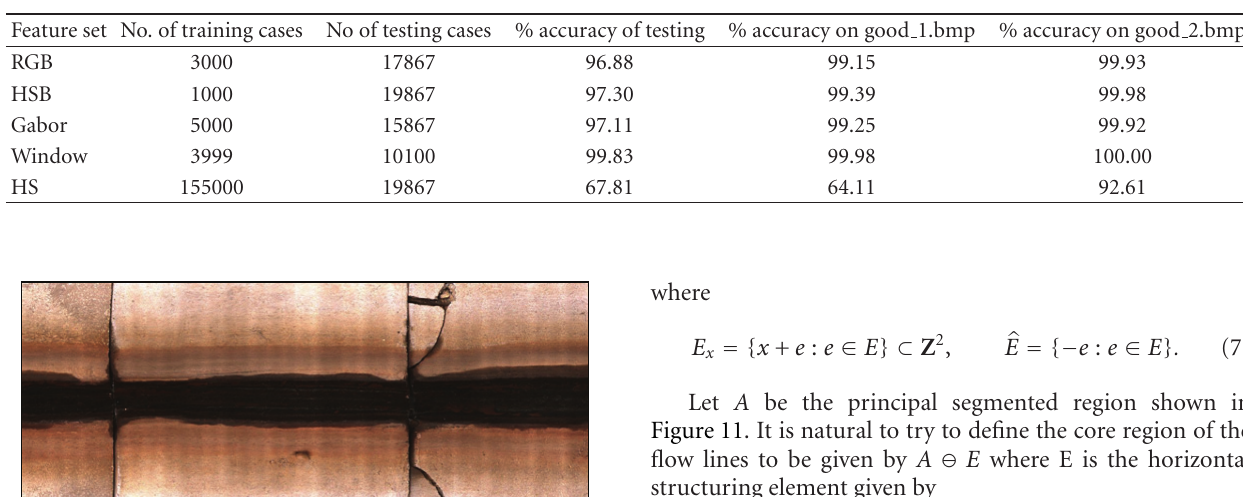
Table 2: Classifier test results.